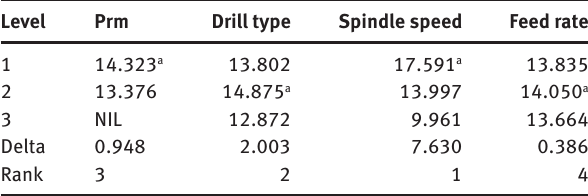
Table 7: Response table for S/N for tool wear.